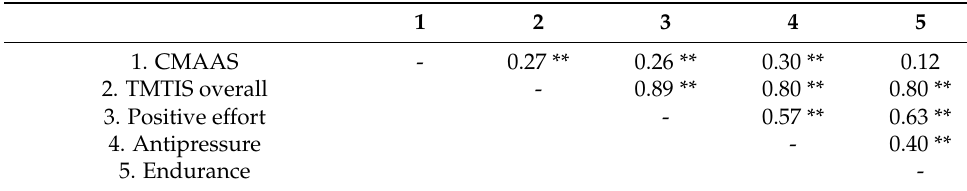
Table 3. Pearson correlation coefficients for CMAAS and